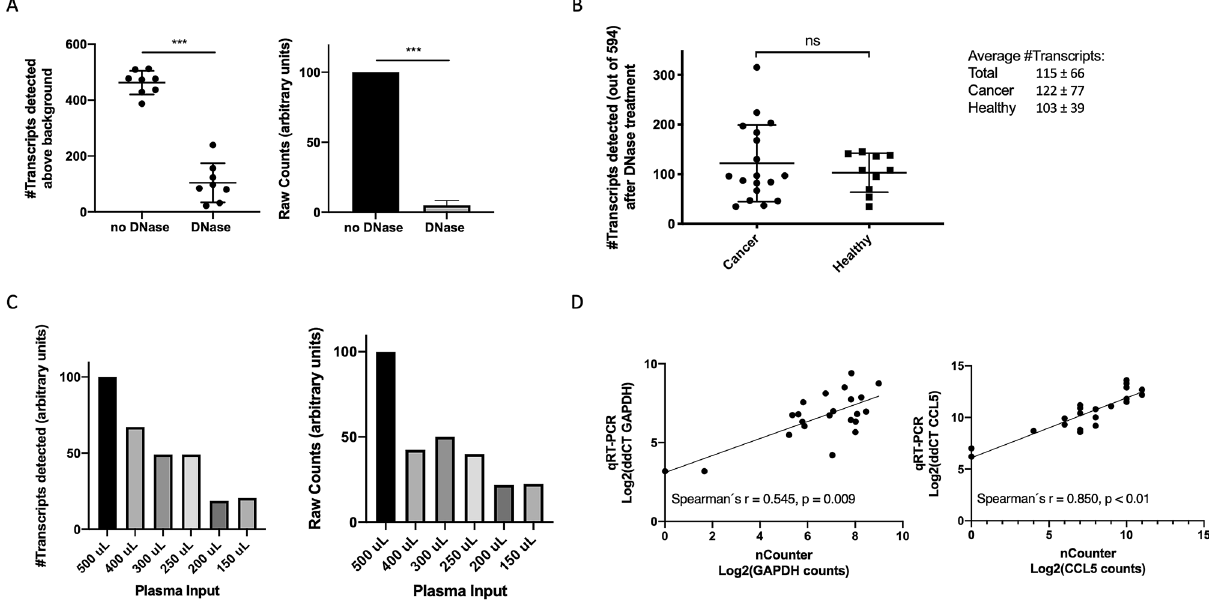
Figure 4. Effect of DNase treatment on the number of transcripts detected, total counts, and additional validation experiments. ( A ) Number of transcripts detected (left) and total nCounter counts (right) in non- DNase vs. DNase treated EV samples ( p < 0.001 in a two-tailed Mann–Whitney U test, in both cases). ( B ) Number of transcripts detected in EVs from cancer patients and control samples using the Human Immunology v2 nCounter panel, after DNase treatment ( p = 0.916 in a two-tailed Mann–Whitney U test). ( C ) Effect of input plasma volume (150–500 μL) on the final number of transcripts detected (left) or total nCounter counts (right), after DNase treatment. Results were normalized to the counts corresponding to 500 μL plasma. ( D ) Comparison of Log2 counts by nCounter versus ddCT values by qRT-PCR for GAPDH and CCL5 in 22 samples. Spearman’s correlation coefficient is indicated. NS, not